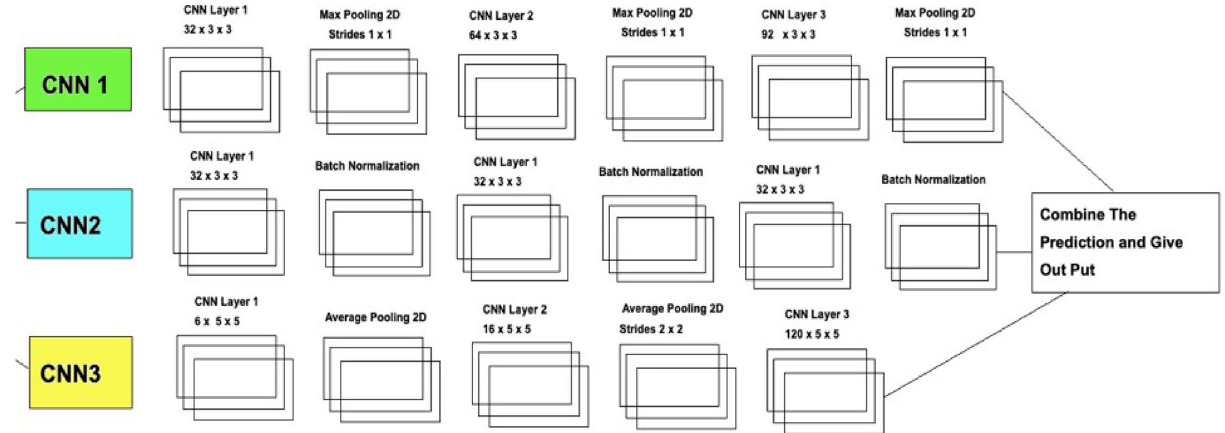
Figure 5. Deep ensemble 2D CNN